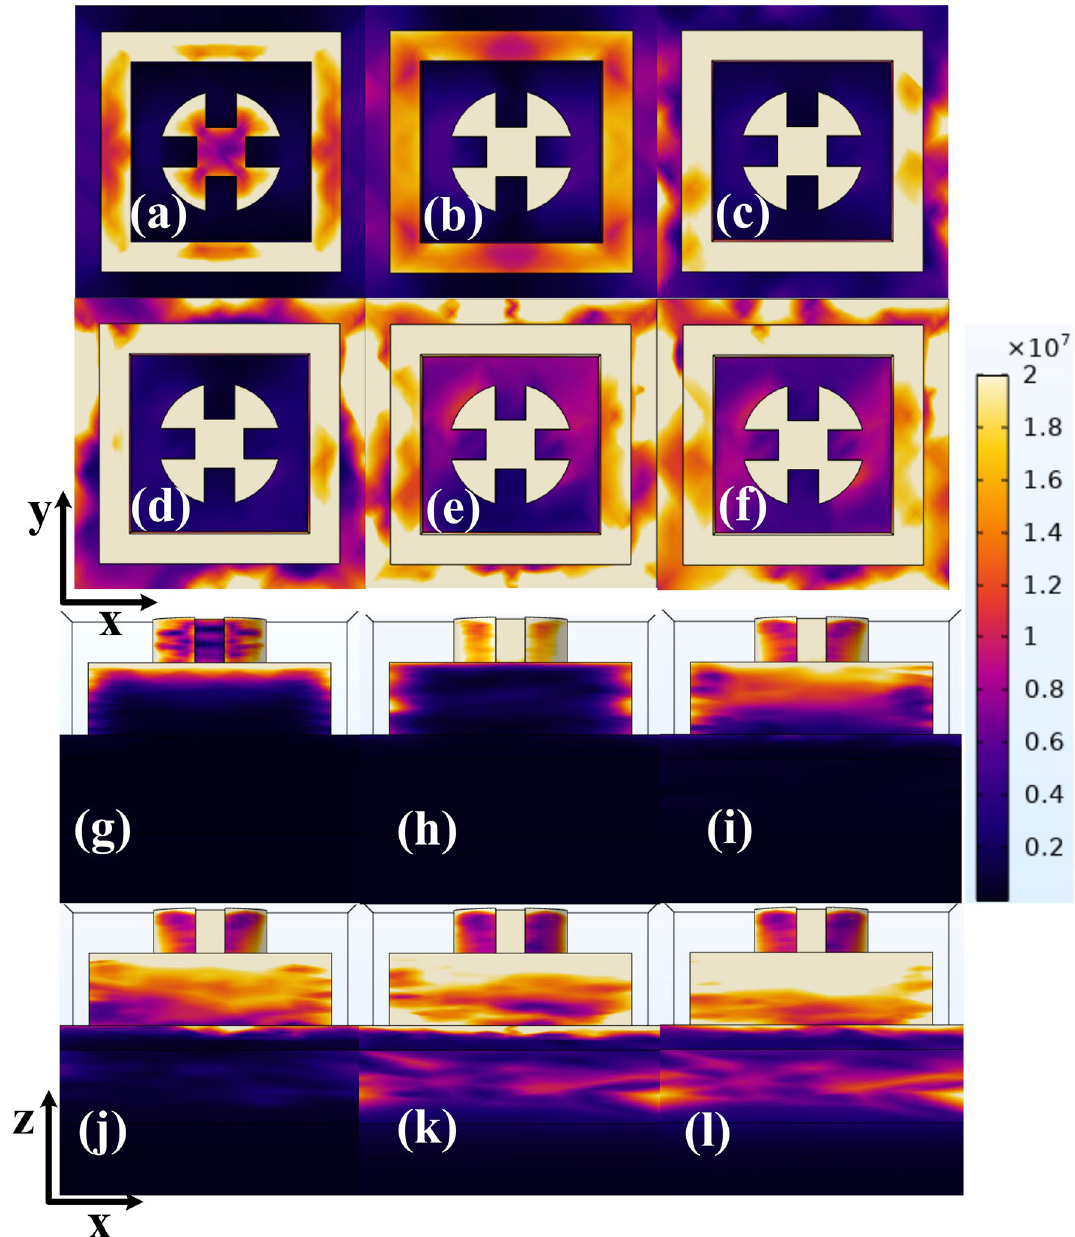
Figure 6. Representation of Electric field distribution of the developed UWBSEA at the six near perfect absorption peaks with two different views i.e., XY and XZ, respectively ( a,g ) 0.22 µm, ( b,h ) 0.56 µm, ( c,i ) 1.5 µm, ( d,j ) 1.79 µm, ( e,k ) 2.63 µm, ( f,l ) 2.69